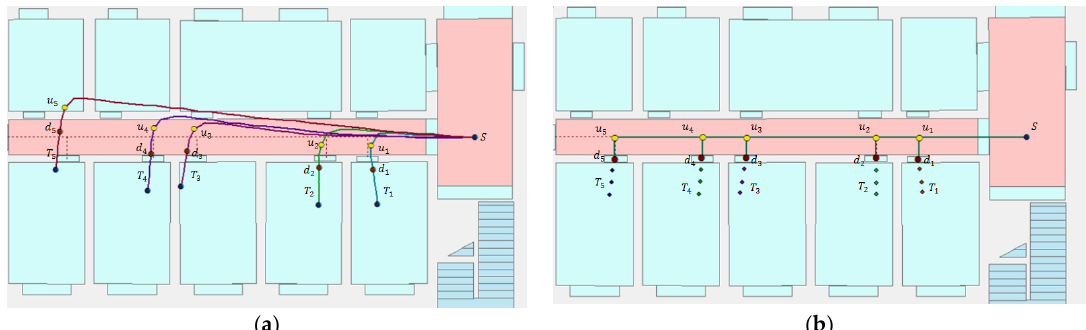
(cid:1856) – (cid:1856) (cid:2869) (cid:2869)(cid:2868) ), which were detected by HAR and the direction sensors.